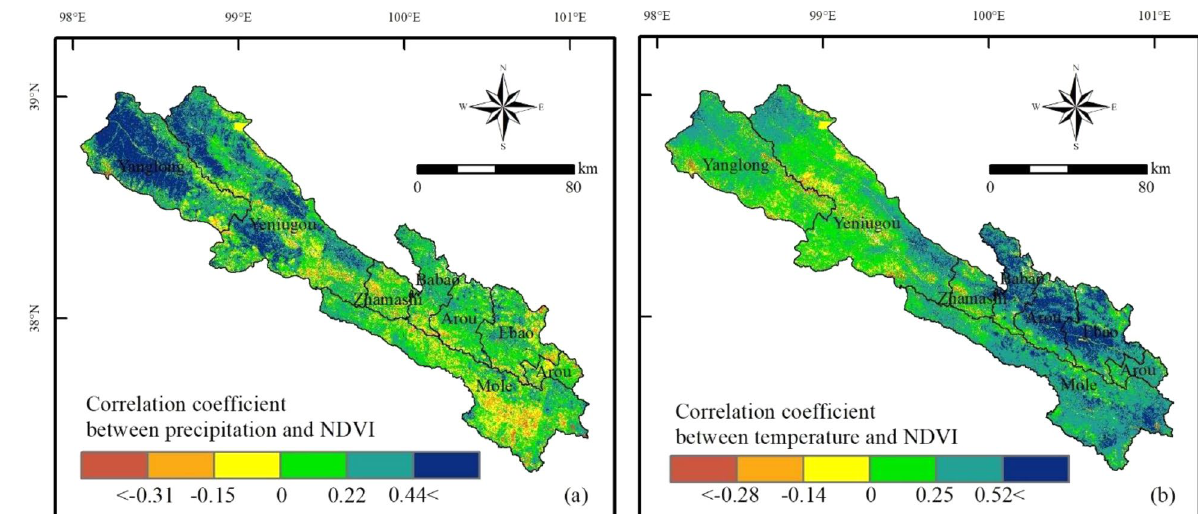
Figure 10. Correlation coefficients between NDVI and precipitation ( a ) and temperature ( b ). The map was generated by ArcGIS 10.2, URL: https:// www. esri. com.